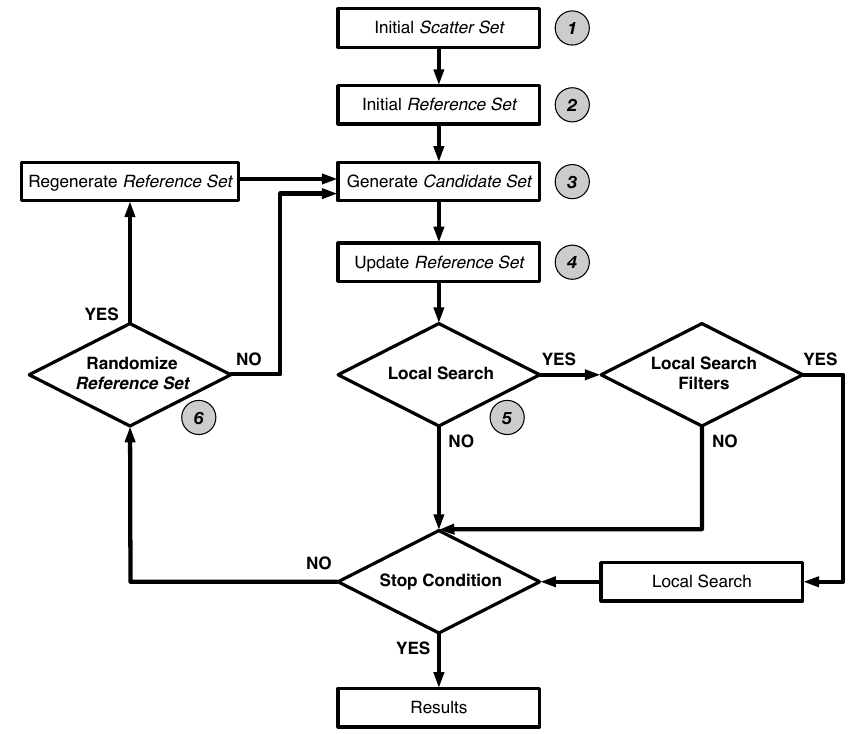
Figure 2. Scatter search algorithm design as presented in [21]. See main text for